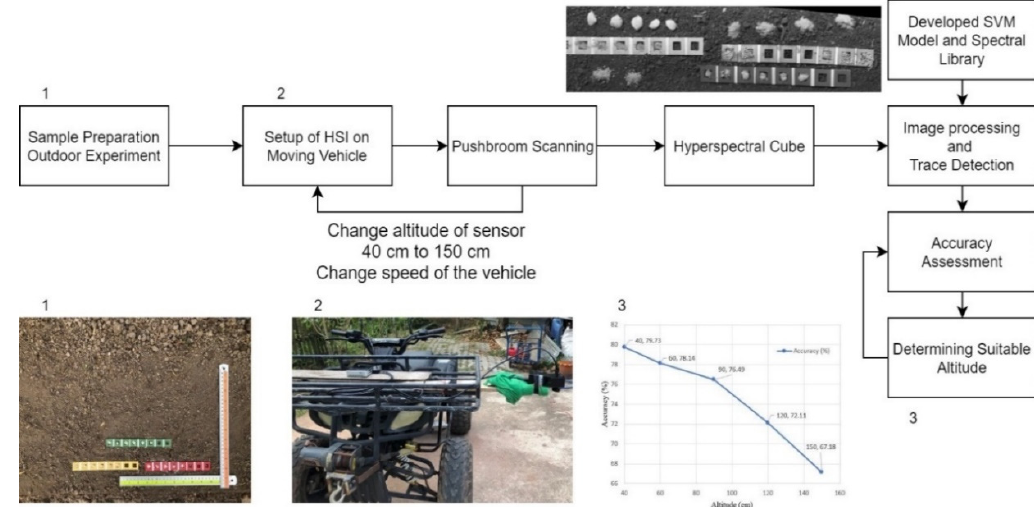
Figure 3. Steps for conducting experiment to suggest altitude of sensor in outdoor conditions.